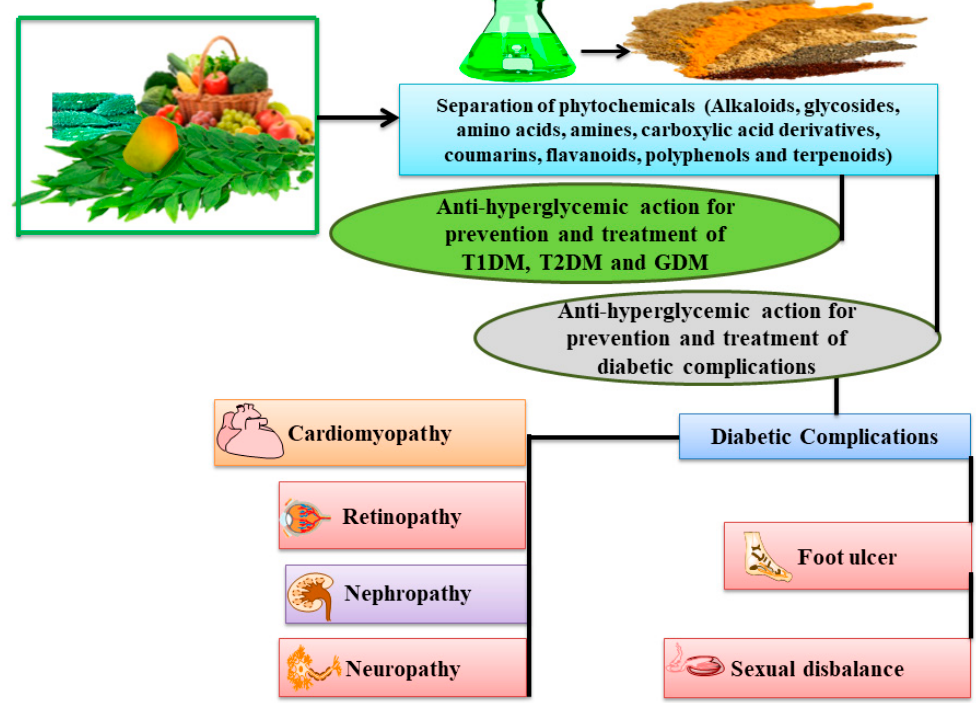
Figure 5. An overview for prevention and treatment of diabetes and its associated complications by phytoconstituents.